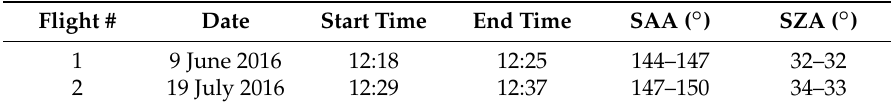
Table 2. Flights, times, and solar geometry (solar azimuth angle (SAA) and solar zenith angle (SZA)). Time is local time (UTC + 2 h). The start time indicates the time at which the first used image was taken and the end time indicates the time at which the last used image was taken.